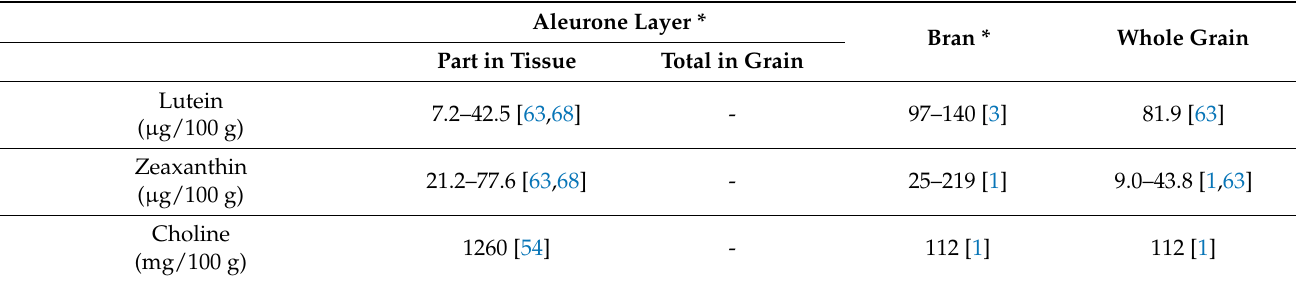
Bran * Whole Grain